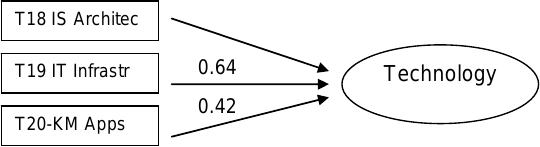
Figure 6: Relative weights of Technology indicators